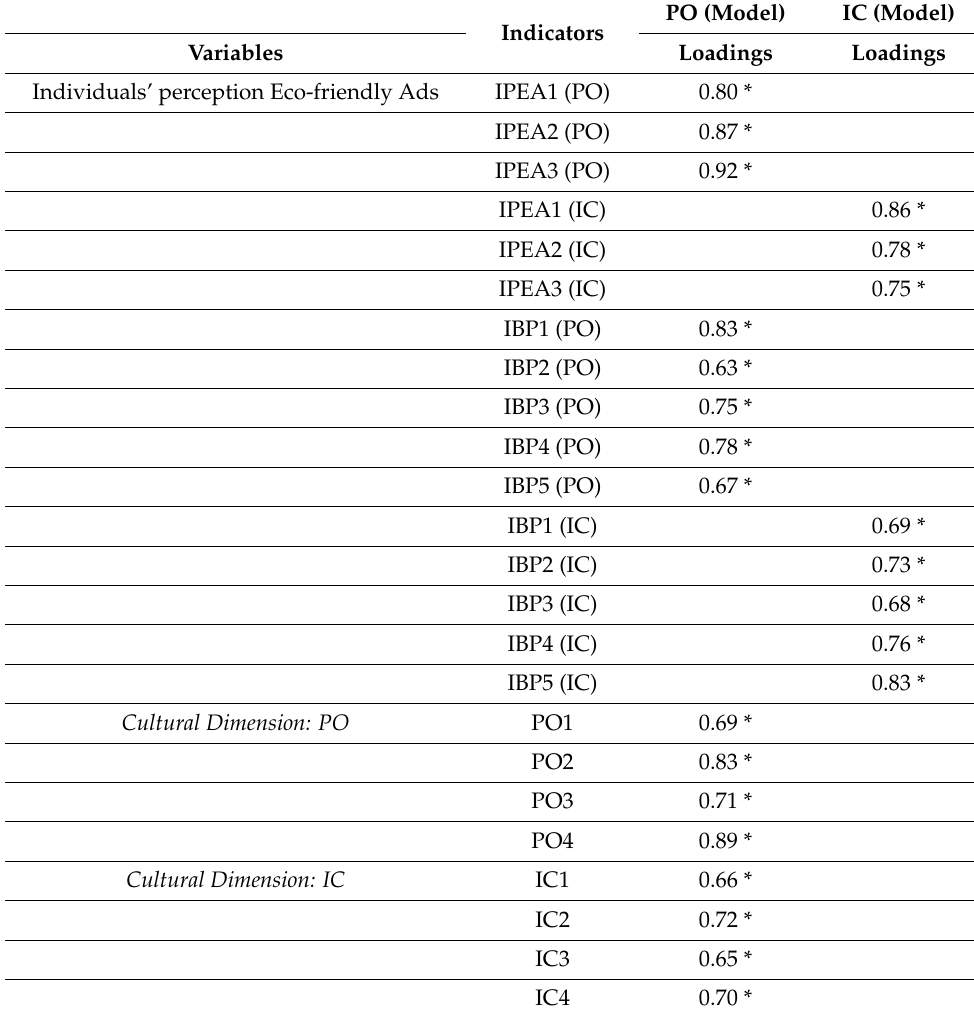
Table 4. Standardized loadings.